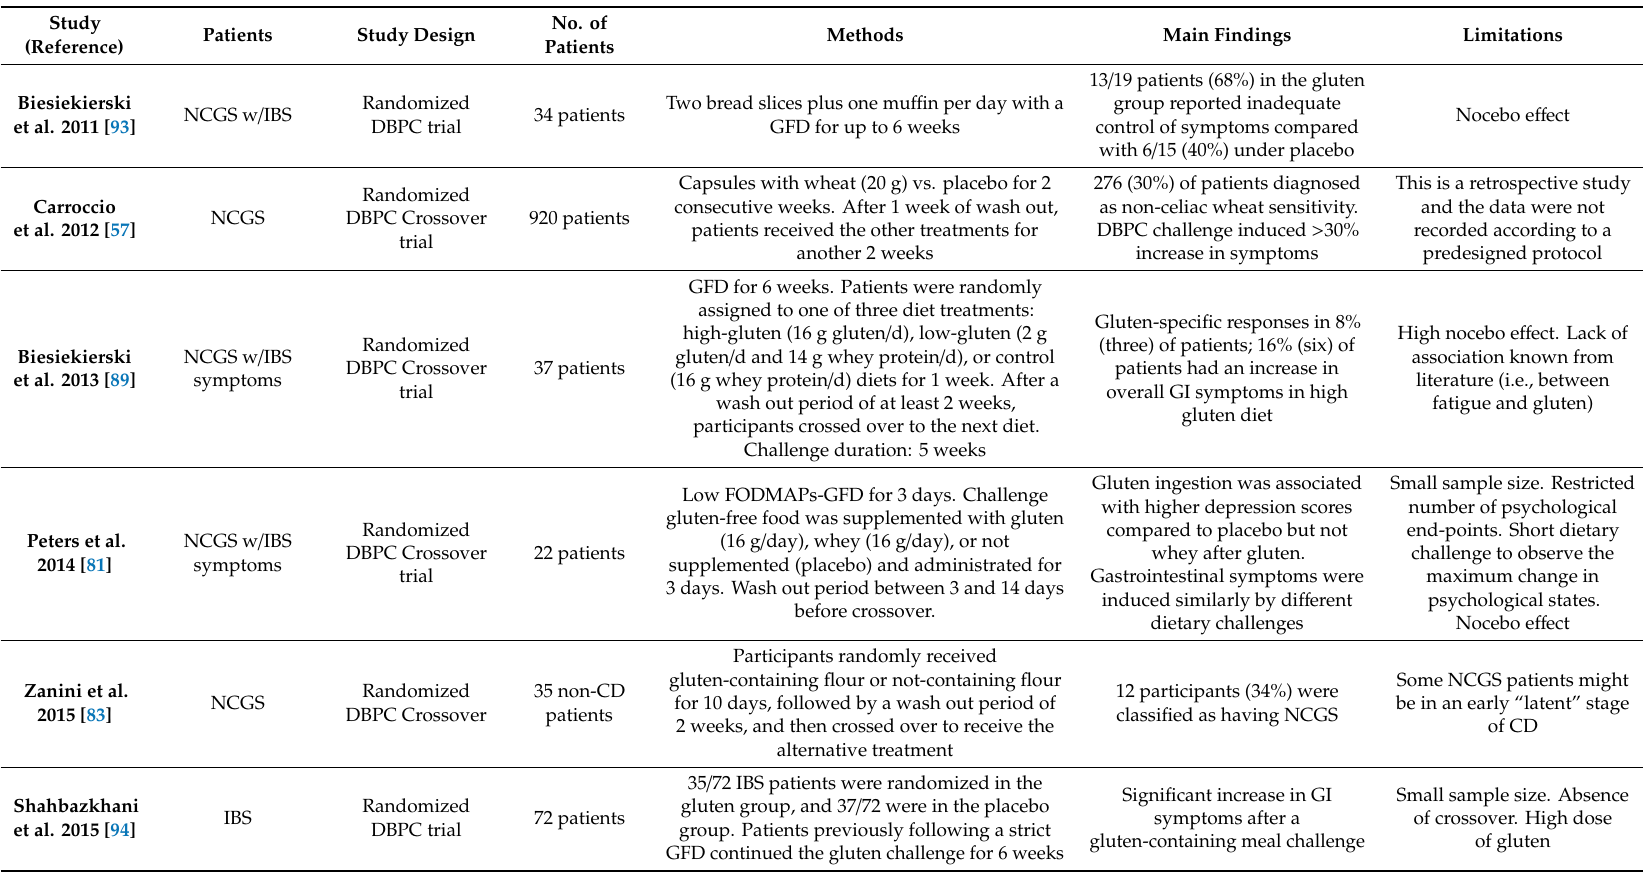
Table 1. A summary of the clinical studies that evaluated the e ff ect of gluten re-challenge in NCGS patients after GFD. GCD, gluten-containing diet; GFD, gluten-free diet; NCGS, non-celiac gluten sensitivity; IBS, irritable bowel syndrome; CD, celiac disease; DBPC, double-blind placebo-controlled; FODMAP,